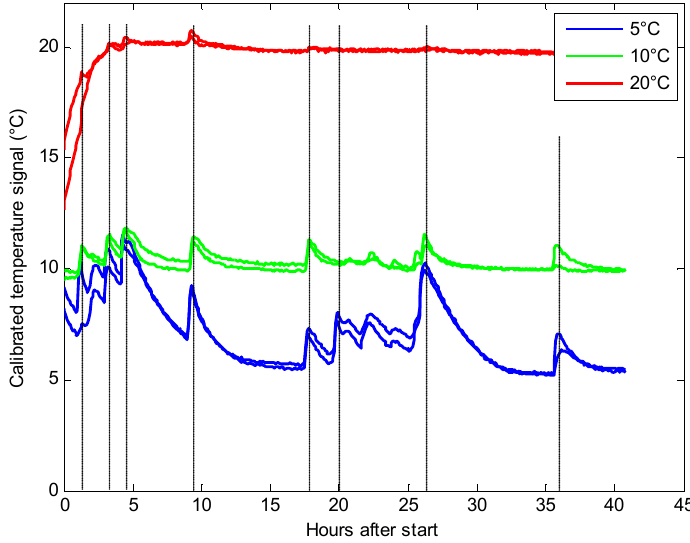
Figure 2. The calibrated temperature signals from six sensors placed at 5 °C (blue lines), 10 °C (green lines) and 20 °C (red lines) at hours after initiating the experiment. The grey, vertical lines represent the time-points were reference measurements were performed.